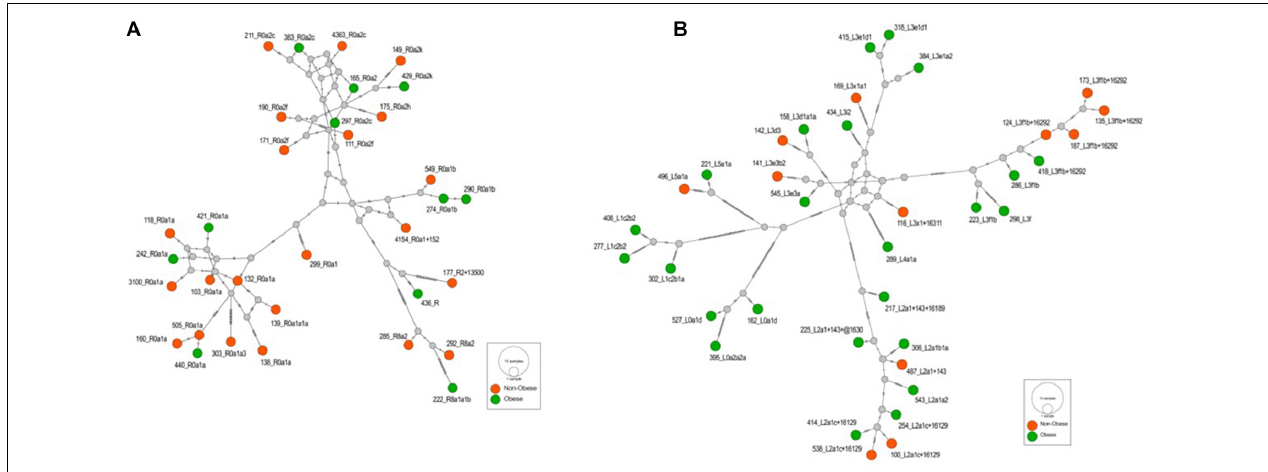
FIGURE 4 | (A) The Median-Joining network of the haplogroup R that is associated with the reduced risk of obesity in the Kuwaiti population. The hatch marks on the edges denote nucleotide positions. (B) The Median-Joining network of the haplogroup L that is associated with the increased risk of obesity in the Kuwaiti population. The hatch marks on the edges denote nucleotide positions.